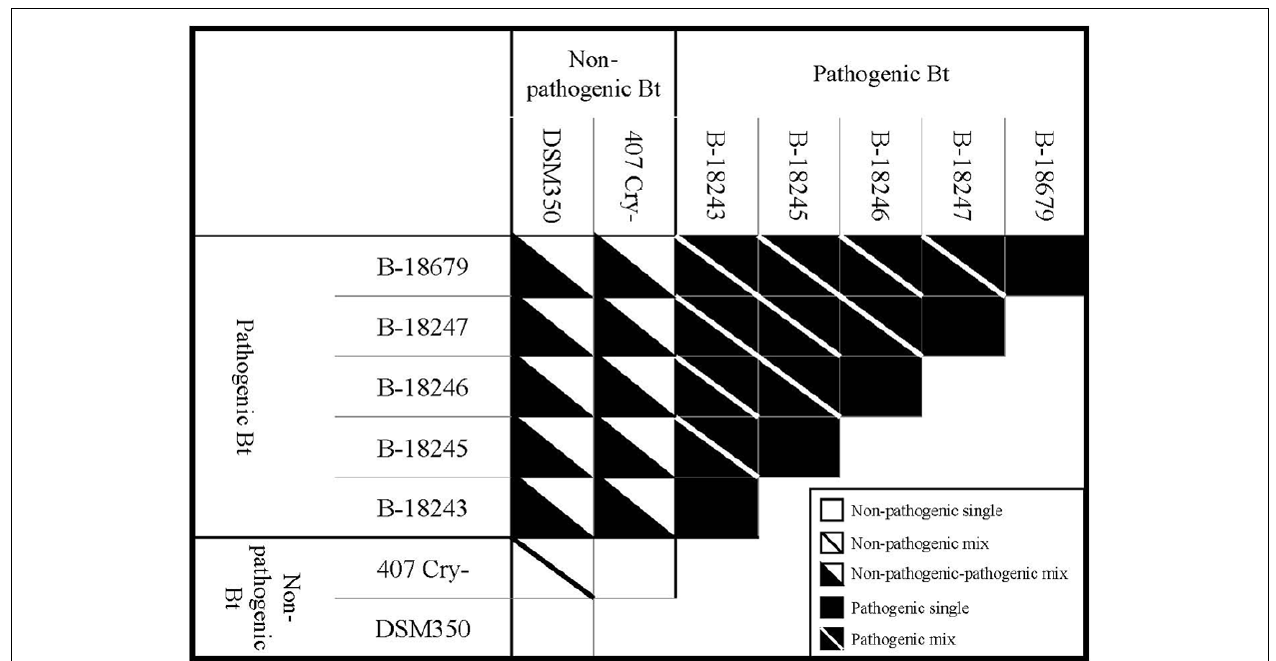
FIGURE 1 | Schematic overview of the experimental design showing different treatments and different strain combinations within each treatment. Every strain combination was replicated four times, except for survival of the combination of 407 Cry- and B-18247 (three